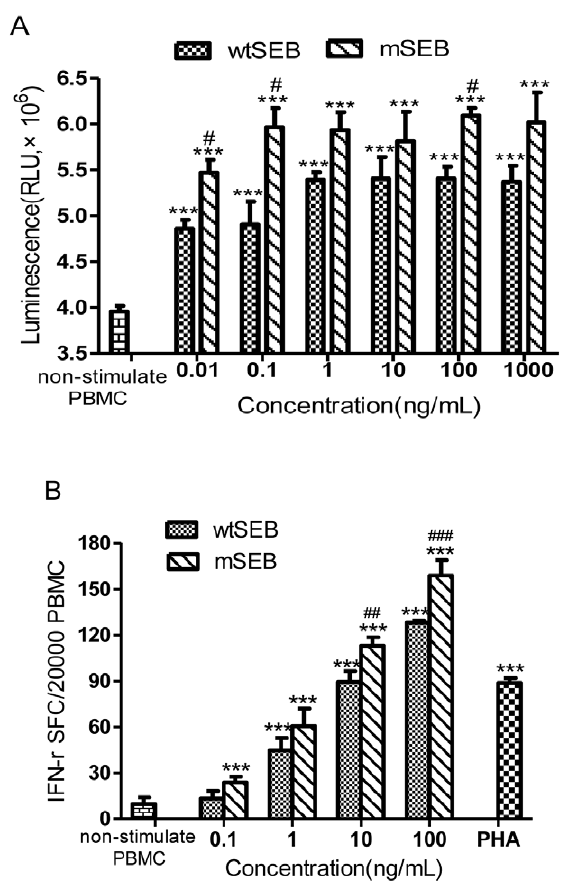
Figure 3. Invitro activation of lymphocytes. (A) Proliferation of PBMCs stimulated by wtSEB and mSEB. Comparison versus non- stimulated PBMCs: ** P , 0.01, *** P , 0.001. Comparison versus wtSEB stimulated PBMCs at the same dose: # P , 0.05. (B) Secretion of IFN- c by mSEB induced human T cells. Histogram of IFN- c secreting spot forming cells (IFN- c SFC) in PBMCs induced by different concentrations of mSEB. PHA (2.5 m g/mL) was used as positive control. Comparison versus non- stimulated PBMCs: *** P , 0.001. Comparison versus wtSEB stimulated PBMCs at the same dose: ## P , 0.01, ### P , 0.001.